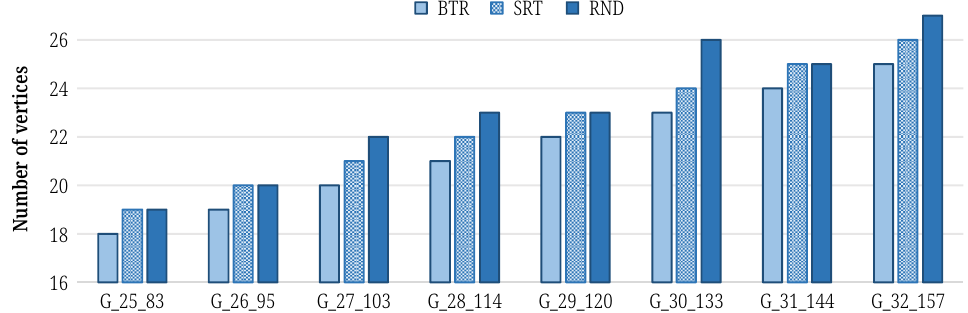
Fig. 8. Comparison between the solution values generated by the three algorithms (for graphs G_25_83–G_32_157)